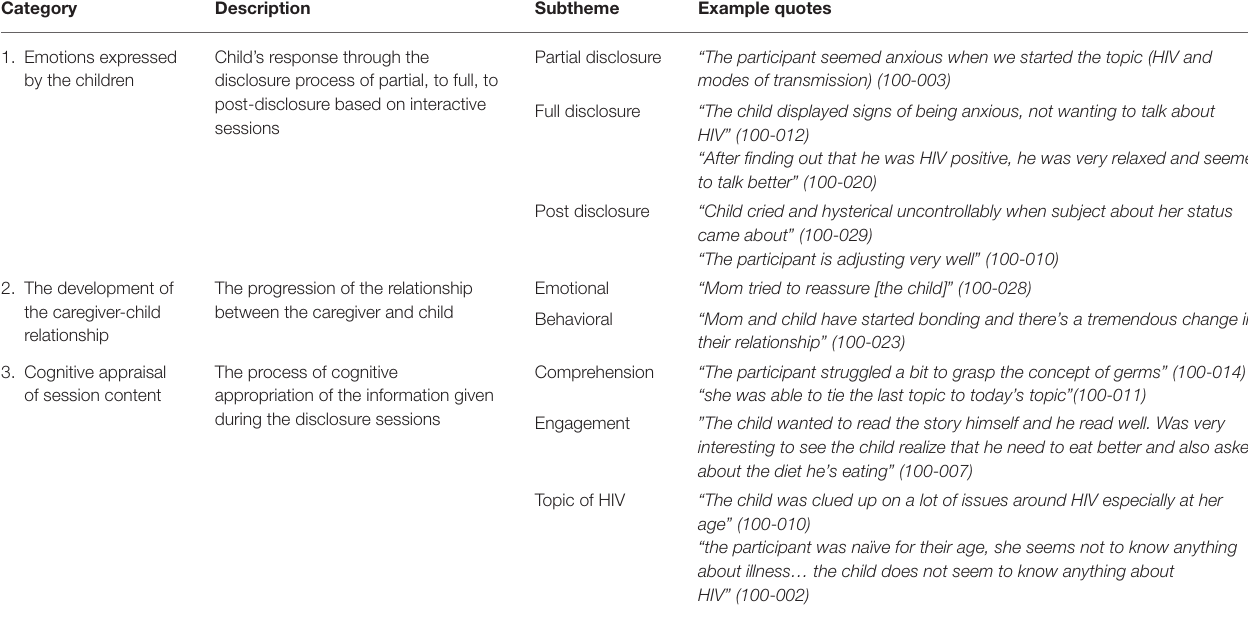
TABLE 3 | Identified categories and